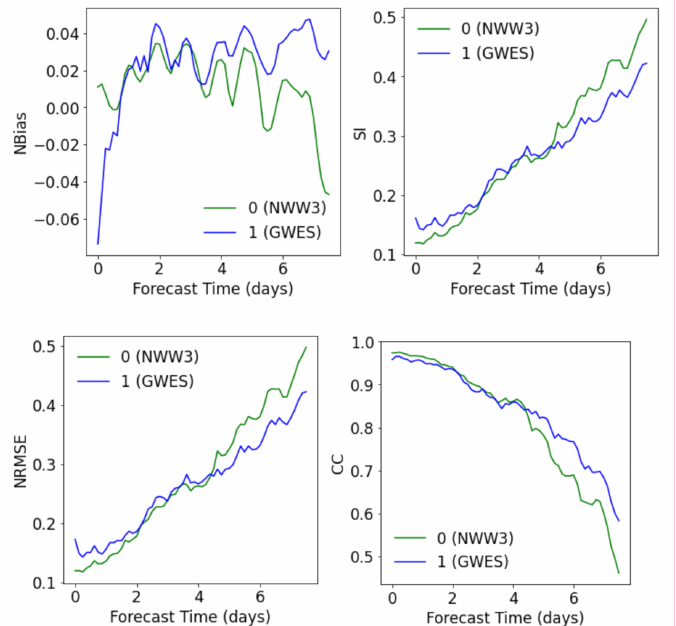
Figure 3. Error metrics of Hs as a function of the forecast time for National Oceanic and Atmospheric Administration WAVEWATCH III (NWW3; in green) and Global Ocean Wave Ensemble Forecast System (GWES; in blue) at 40.50 ◦ N, 69.25 ◦ W. NBias: normalized bias, SI: scatter index, NRMSE: normalized root mean square error, CC: correlation